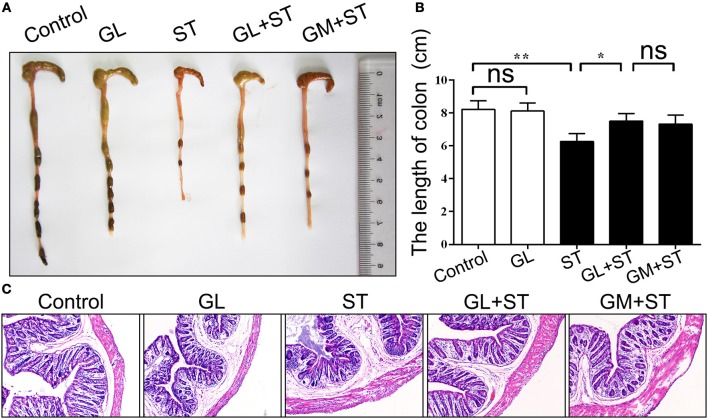
GL administration attenuates cecal and colon damage in ST-infected mice. The mice were randomly divided into five groups: Control, GL, ST infection, GL plus ST (GL prevention group) and GM plus ST (GM prevention group). The mice in the last three groups were infected orally with 4 × 108 CFU of ST and sacrificed 72 h post-infection. Histomorphology (A) and length (B) of the cecum and colon were observed and counted (n = 10/group; *P < 0.05; **P < 0.01), respectively. (C) Representative H&E-stained colon sections from each group of mice (original magnification, 100×).